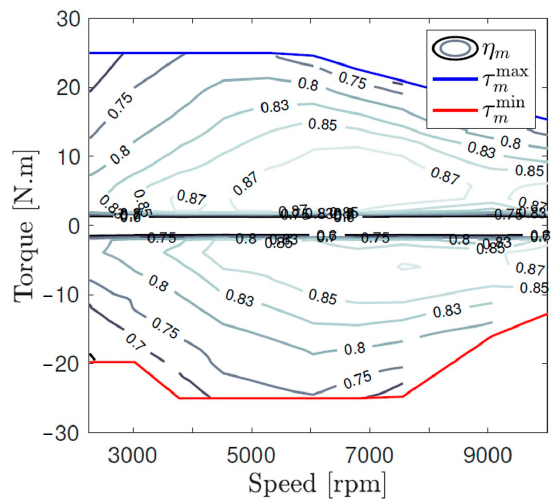
Figure 5. Experimentally generated motor and gear set